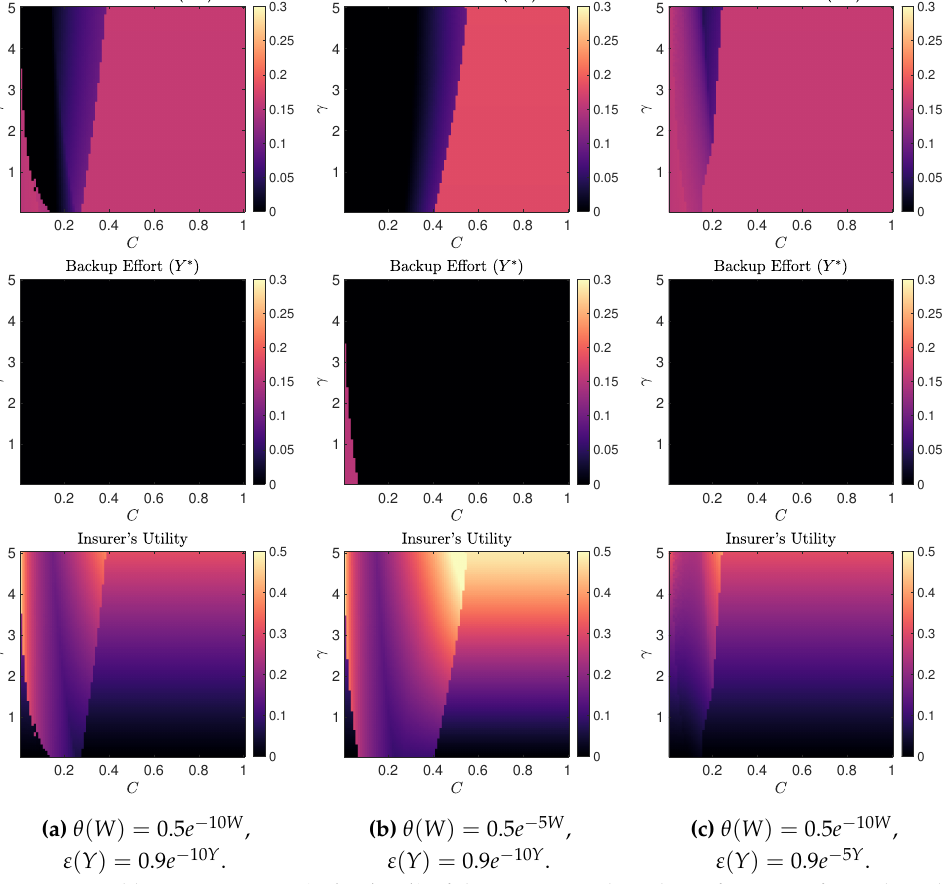
Figure 4. Equilibrium strategies ( W ∗ , Y ∗ , U ∗ ) of the D-I game plotted as a function of C and γ . The i parameters used in this experiment are the same as in Figure 3: the second (resp. third) column has a less effective deterrence (resp. backup) than the first. The most significant observation is that while deterrence is reduced under insurance, it remains positive, whereas backup effort is almost completely abandoned under